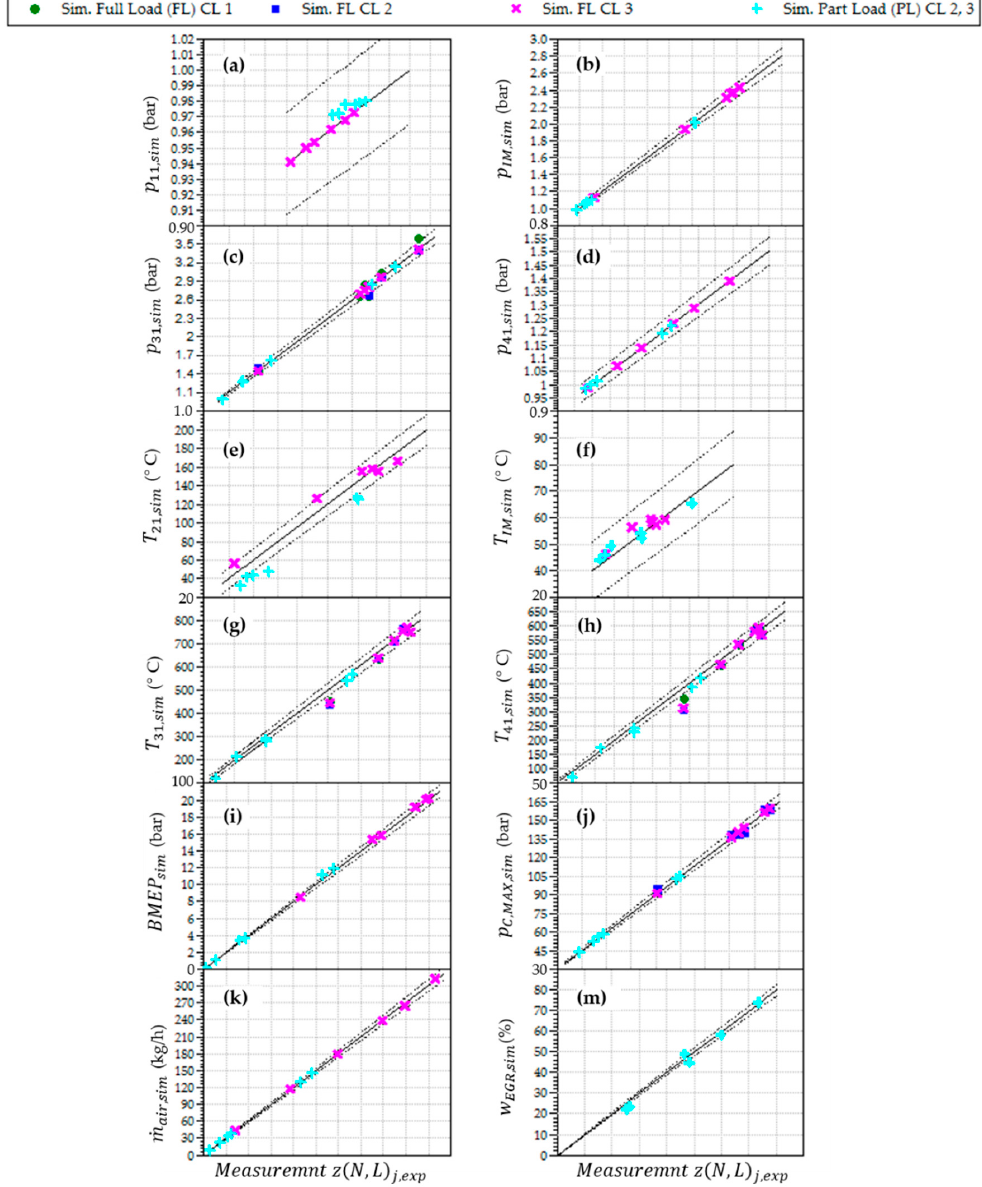
Figure B1. Comparisons of simulation and measurement results at steady-state operation with the included deviation interval ± 3.5% at full-load operating points (1000, 1600, 2000, 2600, 3000 and 3800 rpm) and part-load operating points (775, 1000, 1600, 1800, 2200 and 2400 rpm) after calibration of the applied ICESM using HCM is completed. The subscript sim in the label of the quantities of the y-axes denotes the simulation result whereas CLs 1–3 in the titles of the legend represent the ICESM calibration loops: ( a ) Compressor inlet pressure; ( b ) Intake manifold pressure; ( c ) Exhaust manifold pressure; ( d ) Turbine outlet pressure; ( e ) Compressor outlet temperature; ( f ) Intake manifold temperature; ( g ) Exhaust manifold temperature; ( h ) Turbine outlet temperature; ( i ) Engine BMEP; ( j ) Peak firing pressure; ( k ) Air mass ‐ flow; ( m ) EGR rate.